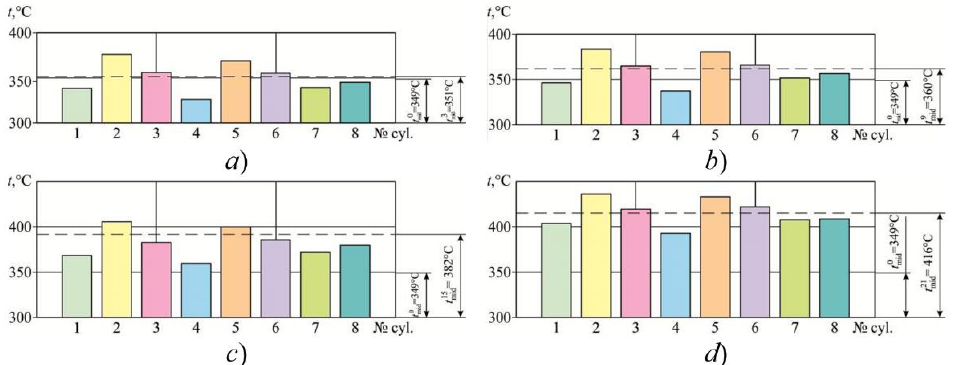
Figure 14. Change in exhaust gas temperature in the cylinders of a 16V32 STX-MAN marine diesel engine at different values of the degree of exhaust gas recirculation (load 95%): ( a ) δ EGR = 3%; ( b ) δ EGR = 9%; ( c ) δ EGR = 15%; ( d ) δ EGR = 21%.